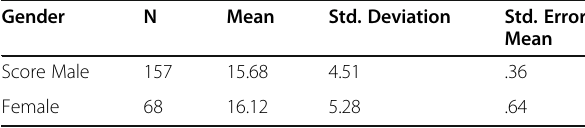
Table 7 Mean Score of Bhutanese Science Teachers ’ Perceptions of the NOS Based on